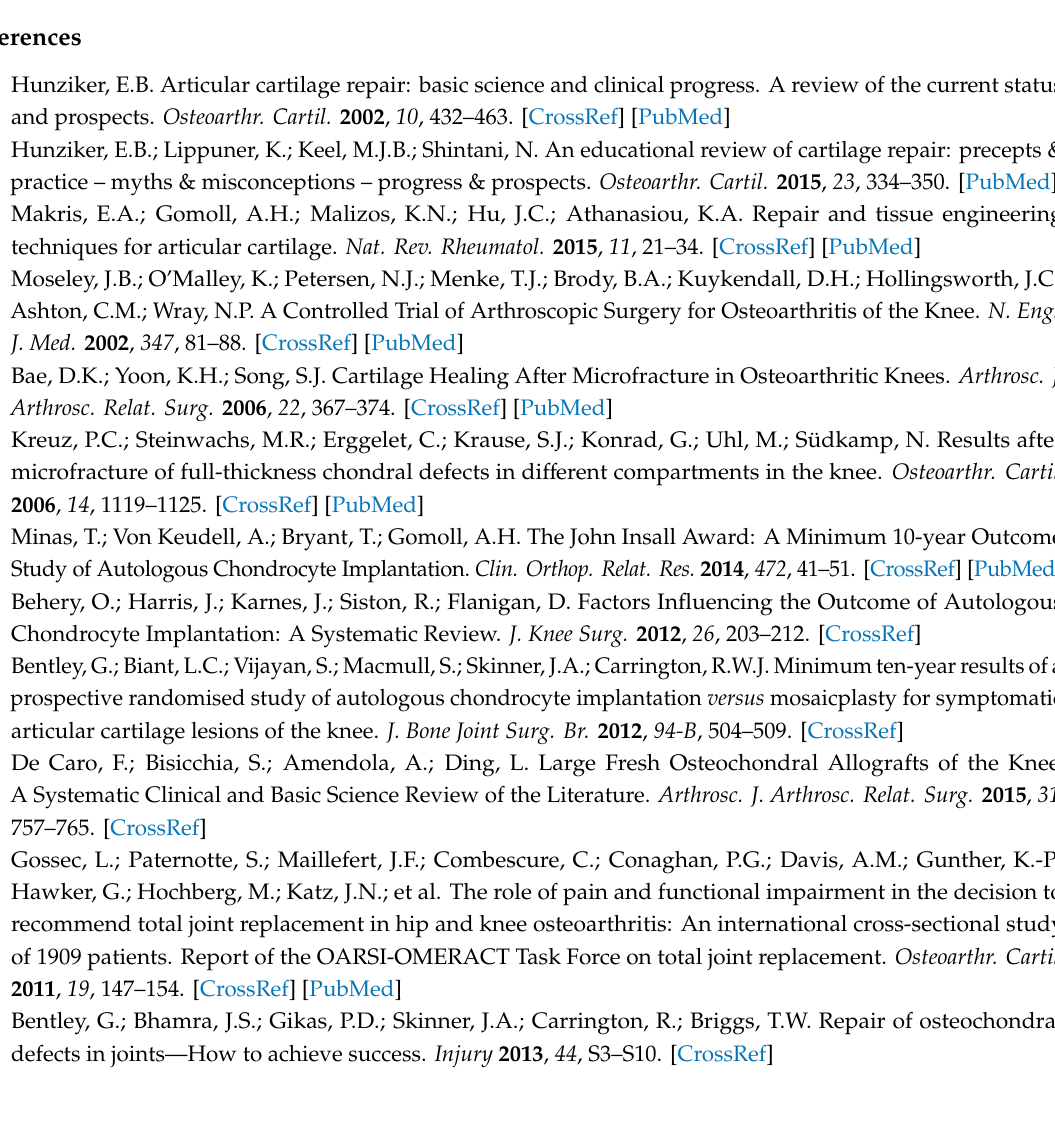
Figure S1: FNDs result in no alteration on cell di ff erentiation derived from hASCs. Figure S2: Appearance of hASC-glue group nude mice before (left) or after one-month (right) implantation. Figure S3: ECM